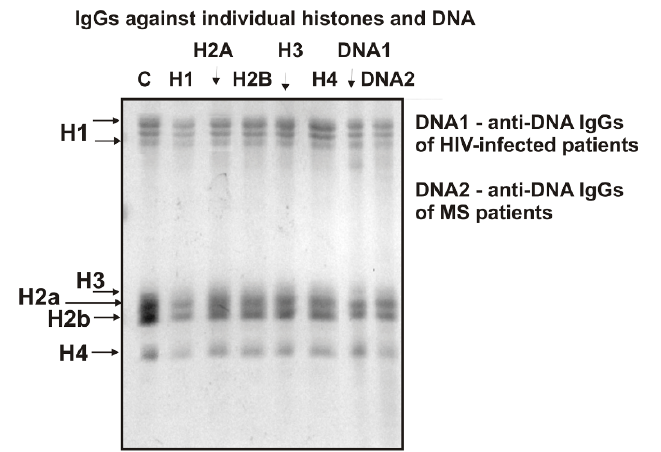
Figure 4. SDS-PAGE analysis of hydrolysis of five histones by IgGs against five individual histones from the blood of MS patients and anti-DNA IgGs of HIV-infected and MS patients. Lane C corre- sponds to the histones incubated without IgGs. The mixture of five histones with IgGs (0.03 mg/mL) and without Abs were incubated for 12 h. Designations of IgGs and diseases are shown in the figure. It can be seen that all IgG preparations hydrolyze five histones to varying